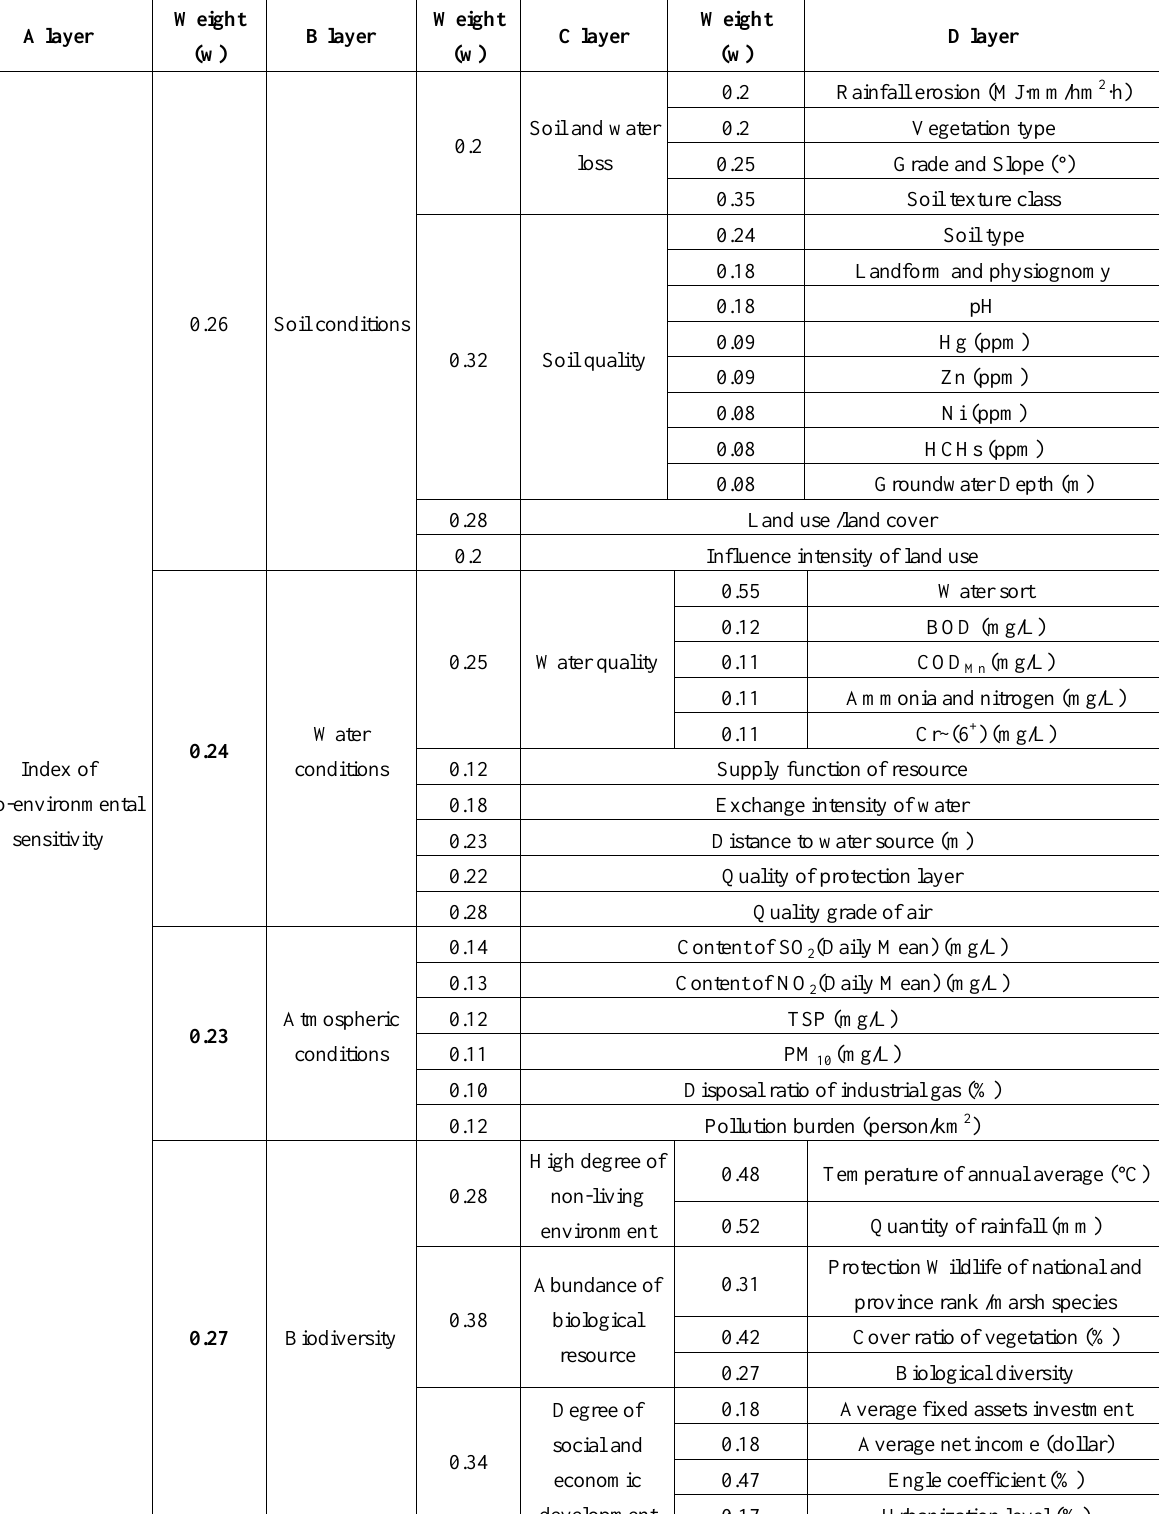
Table 5. Weight of each eco-environmental evaluation